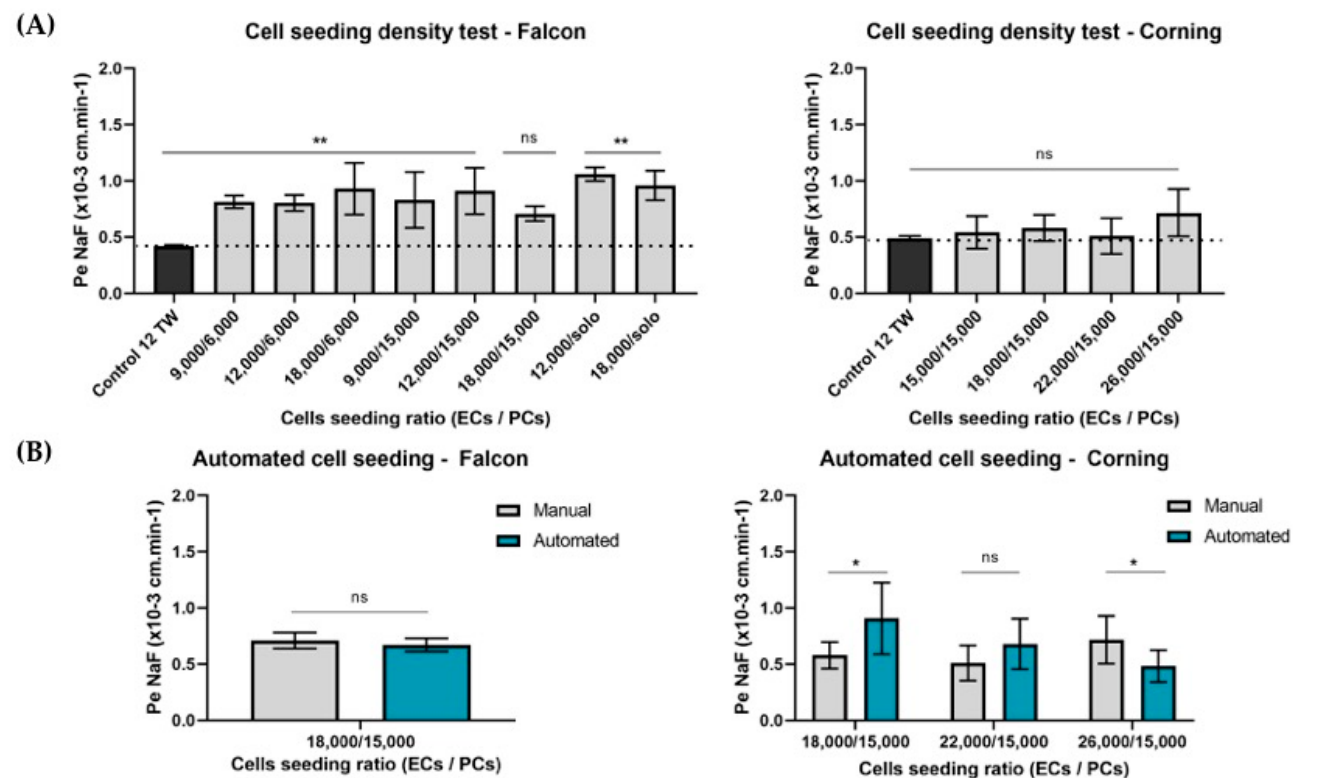
Figure 2. Adaptation of the cell seeding densities for the miniaturized BBB model development. Endothelial cells (ECs) were seeded on the filters of the insert system and pericytes (PCs) in the bottom wells in different densities. ( A )The manual cell seeding density ratio test for the different 96-multiwell system plates by a comparison of the Pe NaF coefficients was used as the integrity marker for the model, obtained from the 12 TW BBB model used as the control ( n = 3 replicates) and the miniaturized systems. Statistical analyses were done using ordinary one-way ANOVA with multiple comparison tests. Significant differences were ** p -value < 0.01, and ns = no significant differences. Hand cell seeding density ratio test in Falcon plates, n = 8 replicates; Corning plates, n = 6 replicates. ( B )Validation of the cell seeding automation test. Falcon plates automated cell seeded by the robot showed no significant differences (ns) in the EC integrity compared with hand seeding. Corning plates showed significant differences according to the cell seeding type: 18,000/15,000 and 26,000/15,000 (ECs/PCs), * p -value < 0.05, and no significant differences (ns, p = 0.109) for the automated cell seeding ratio 22,000/15,000 (ECs/PCs), n = 8 replicates. Statistical analyses were a multiple t- test.